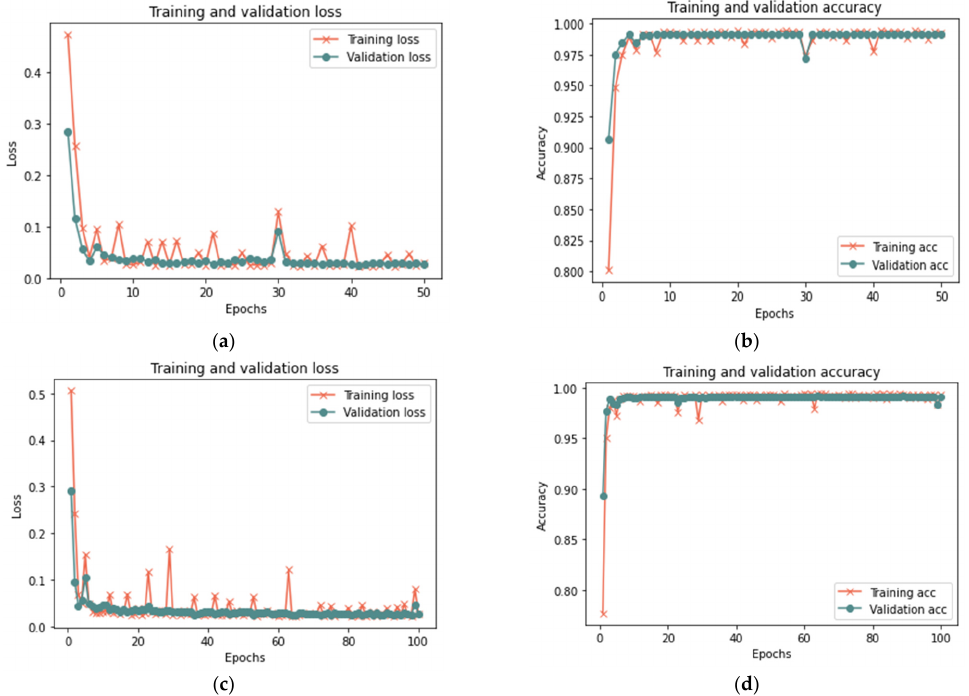
Figure 17. Results of the third scenario with 50% sample size: ( a ) loss at 50 iterations; ( b ) accuracy at 50 iterations; ( c ) loss at 100 iterations; and ( d ) accuracy at 100 iterations.